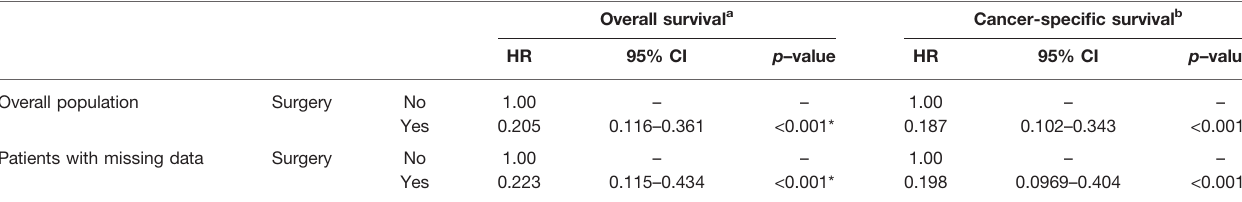
TABLE 3 | Multivariable Cox proportional hazards models in the weighted population.